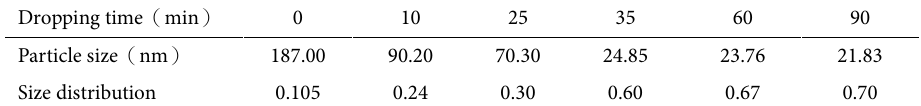
on the microemulsion 4